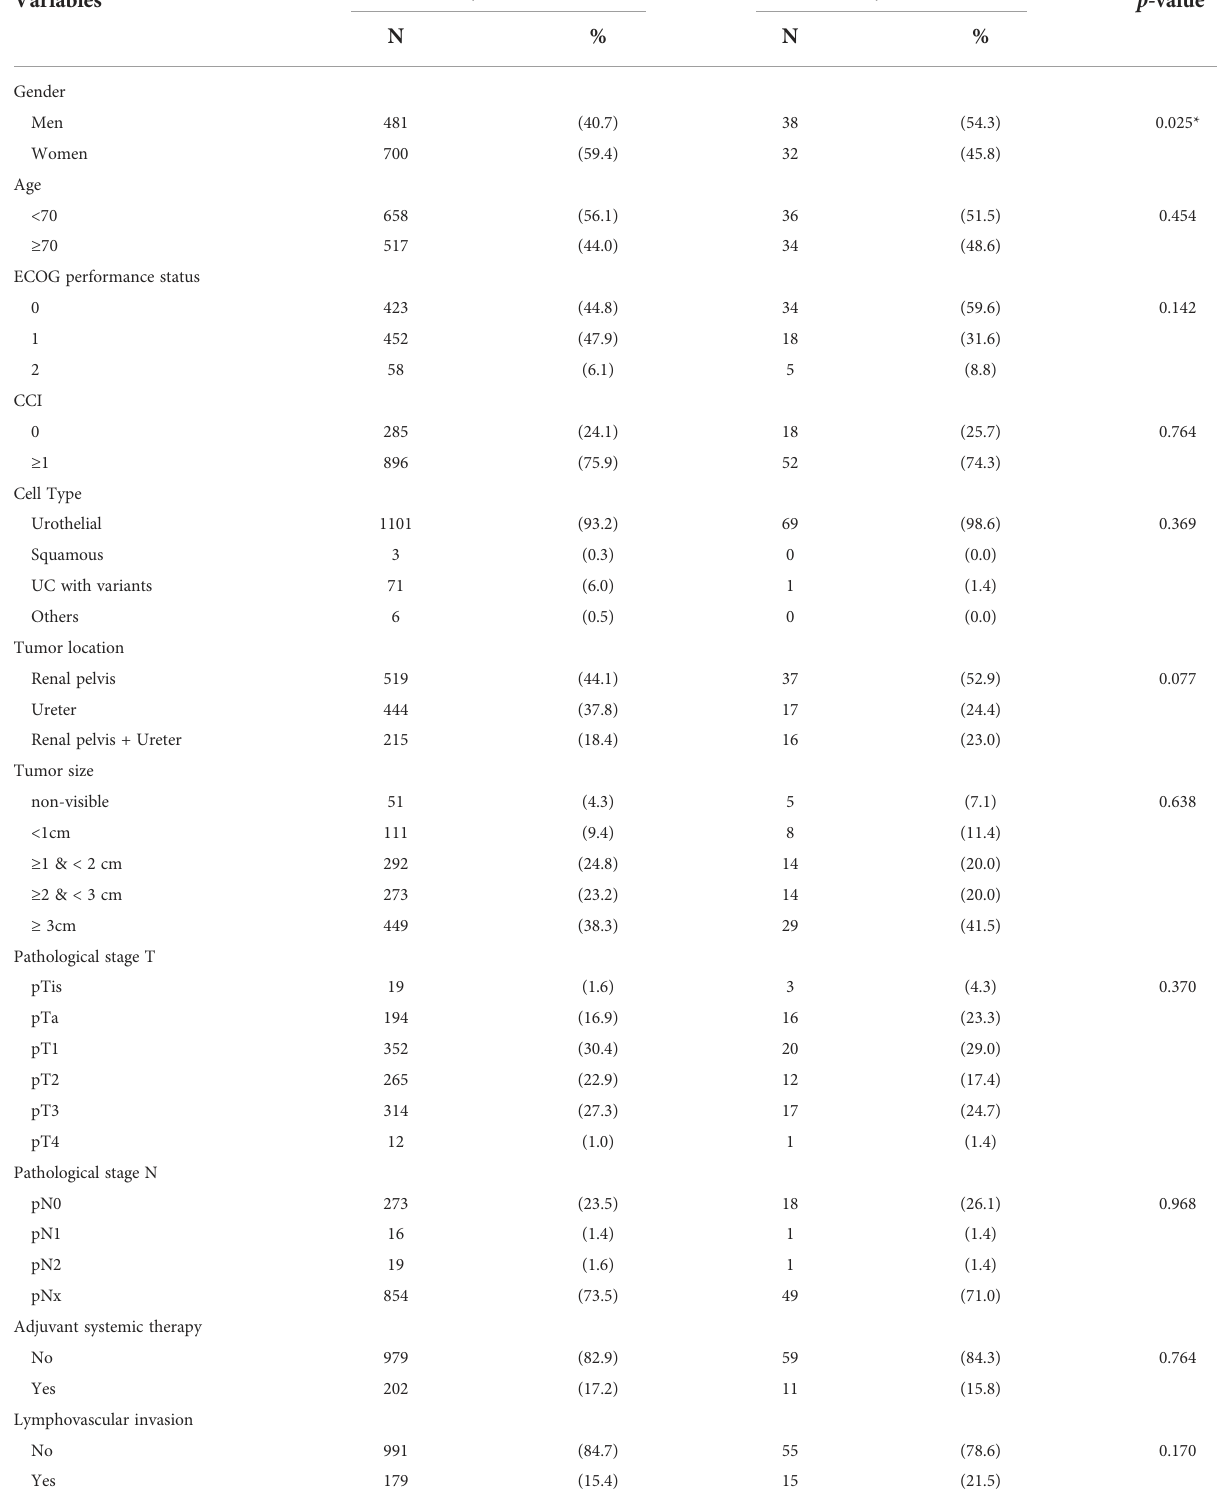
TABLE 1 Baseline demographic data of variables the UTUC